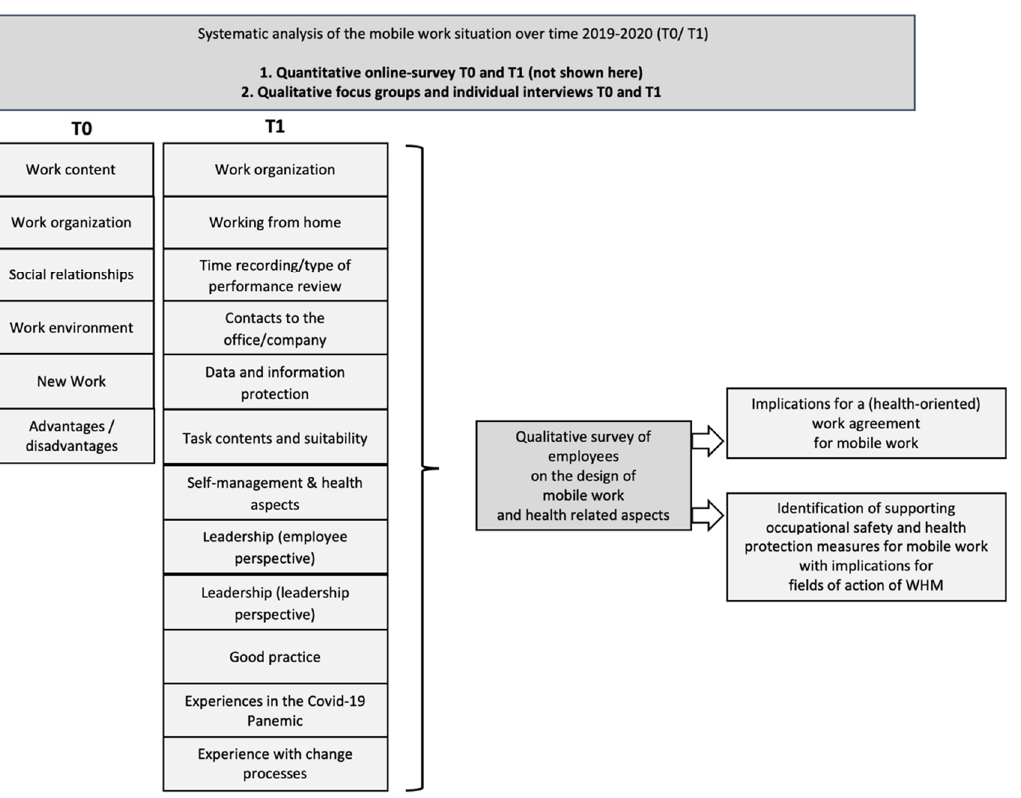
Figure 1. The procedure and representation of the iterative, qualitative research process.